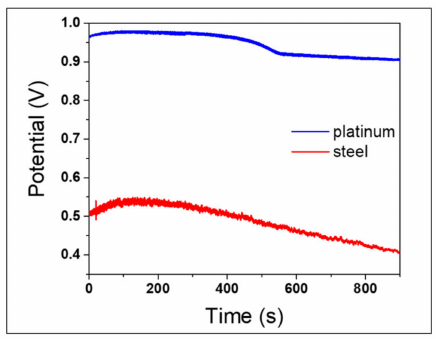
Figure 11. OCP measurements recorded using platinum wire (blue) and steel wire (red) as working